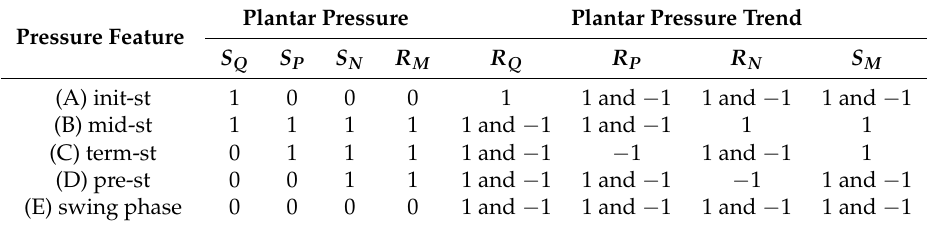
Table 1. Gait characteristics correspondence table in each state. (1 means the force is gradually increasing, and − 1 means the force is gradually decreasing. 0 means the position is not under pressure.)